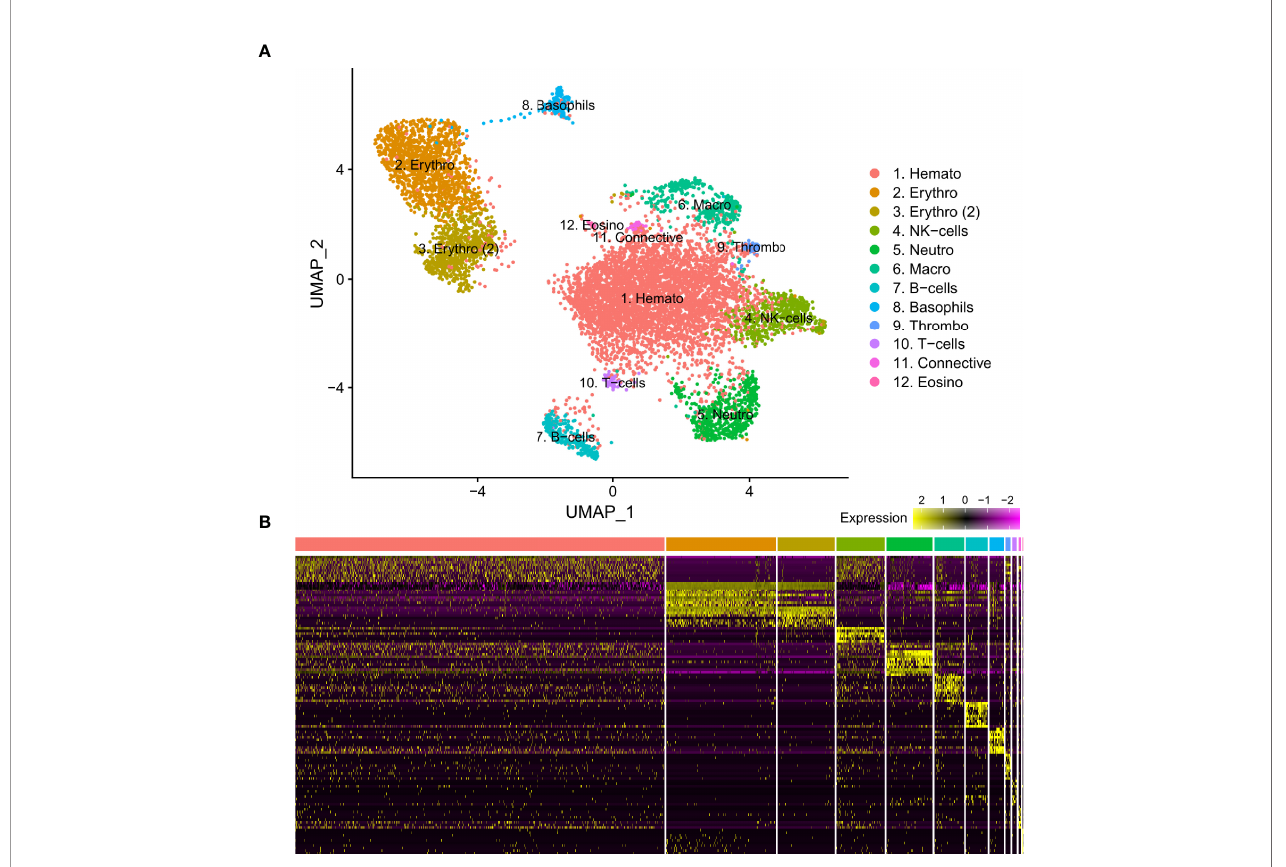
FIGURE 1 | (A) Visual representation of isolated blood and head kidney extracted cell types of Syngnathus typhle using Uniform manifold approximation projection (UMAP). Cell clusters characterized by differentially expressed gene markers associated with speci fi c cell sub-types. All markers associated with immune function previously reported in humans and/or fi sh species. Two erythrocyte clusters are represented with the second highlighted as such (2). Full names for all clusters are as follows: 1. Hematopoietic cells, 2 and 3. Erythrocytes, 4. Natural killer cells, 5. Neutrophils, 6. Macrophages, 7. B-cells, 8. Basophils, 9. Thrombocytes, 10. T- cells, 11. Connective tissue cells, 12. Eosinophils. (B) Differential gene expression heatmap highlighting top 10 marker genes, with genes representing rows and cells representing